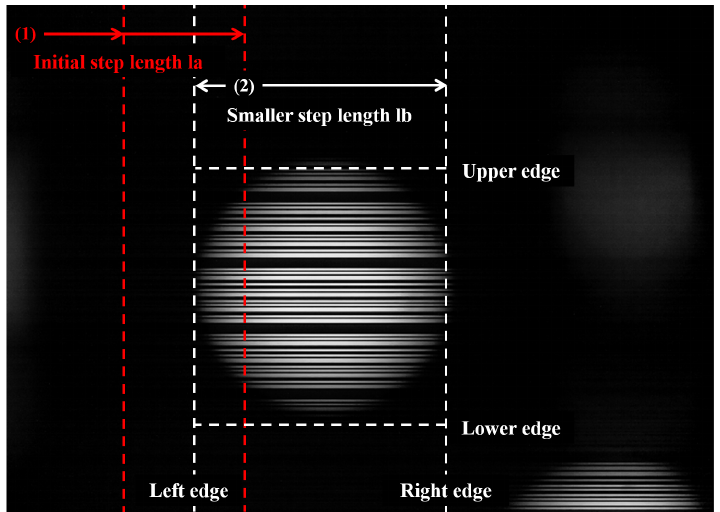
Figure 4. Lightweight ROI detection algorithm for extracting VLP-LED stripe image region.